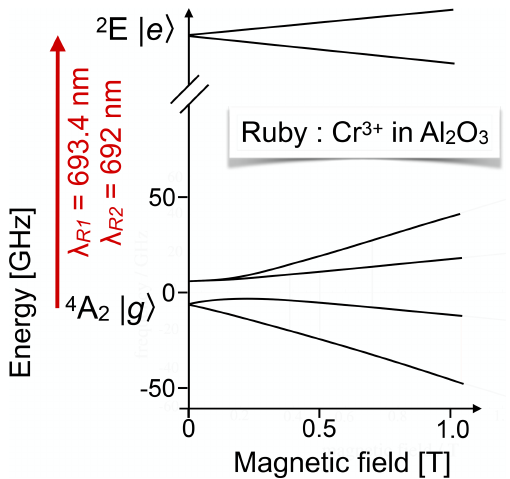
Figure 16. Partial energy level scheme of Cr 3 + in ruby for the states involved in the R 1 and R 2